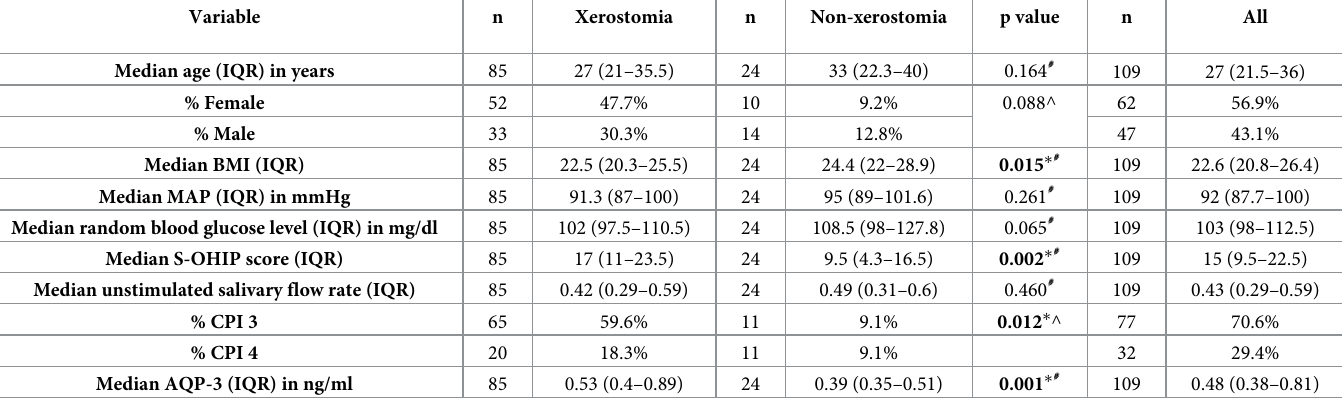
Table 3. Association of xerostomia status with age, sex, general health status, OHRQOL, unstimulated salivary flow rate, periodontal status, and salivary AQP-3 concentration in patients with periodontal disease.